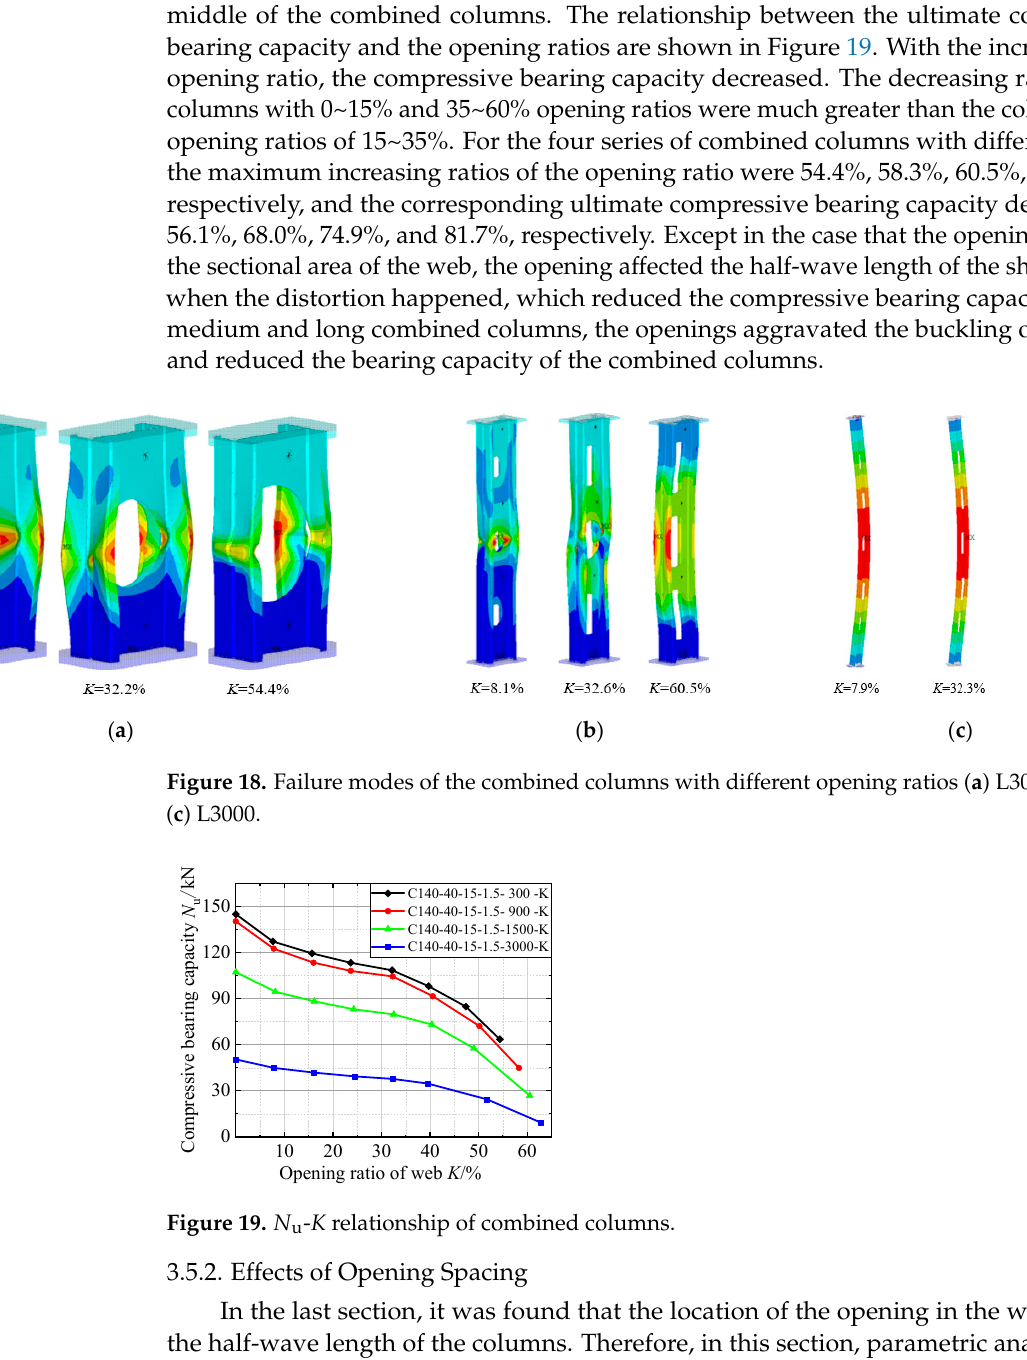
12 of 24 Figure 17. N u - S b relationship curves of the combined columns.